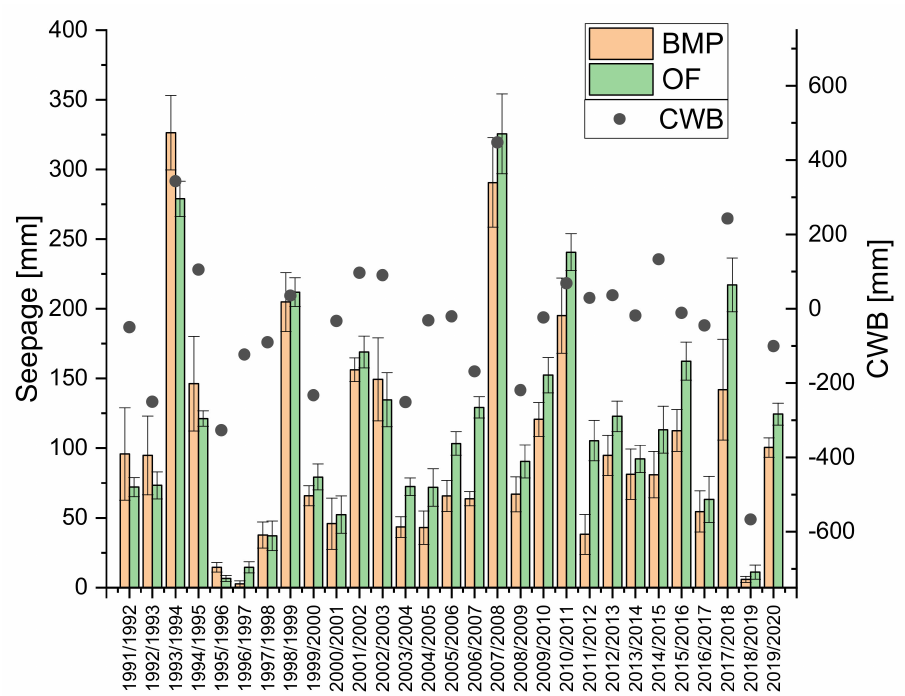
Figure 4. Mean seepage of Organic Farming (OF) and Best Management Practice (BMP) and the corresponding values of the climatic water balance for the study period 1991/92–2019/20 (bars for standard error of means, dots for the climatic water